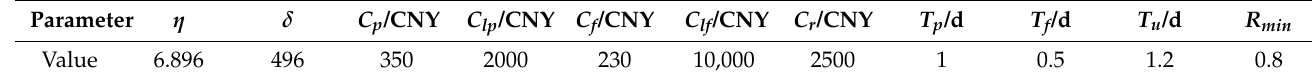
Table 1. Parameter setting table for the power supply module.